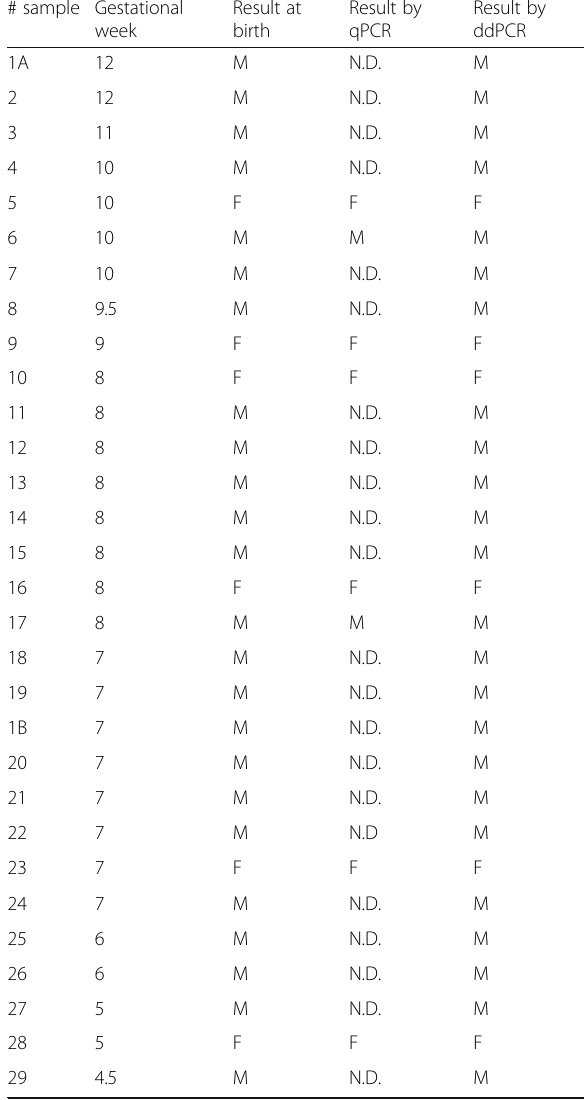
Table 1 Fetal sex determination of circulating cell-free DNAs by qPCR and ddPCR. The actual fetal sex and the diagnostic outcome after fetal sex determination by qPCR and ddPCR were determined for circulating cell-free DNAs obtained from 29 pregnant women at different gestational ages. The samples 1A and 1B were obtained from the same pregnat woman at two different gestational weeks. M male, F female. N.D. not